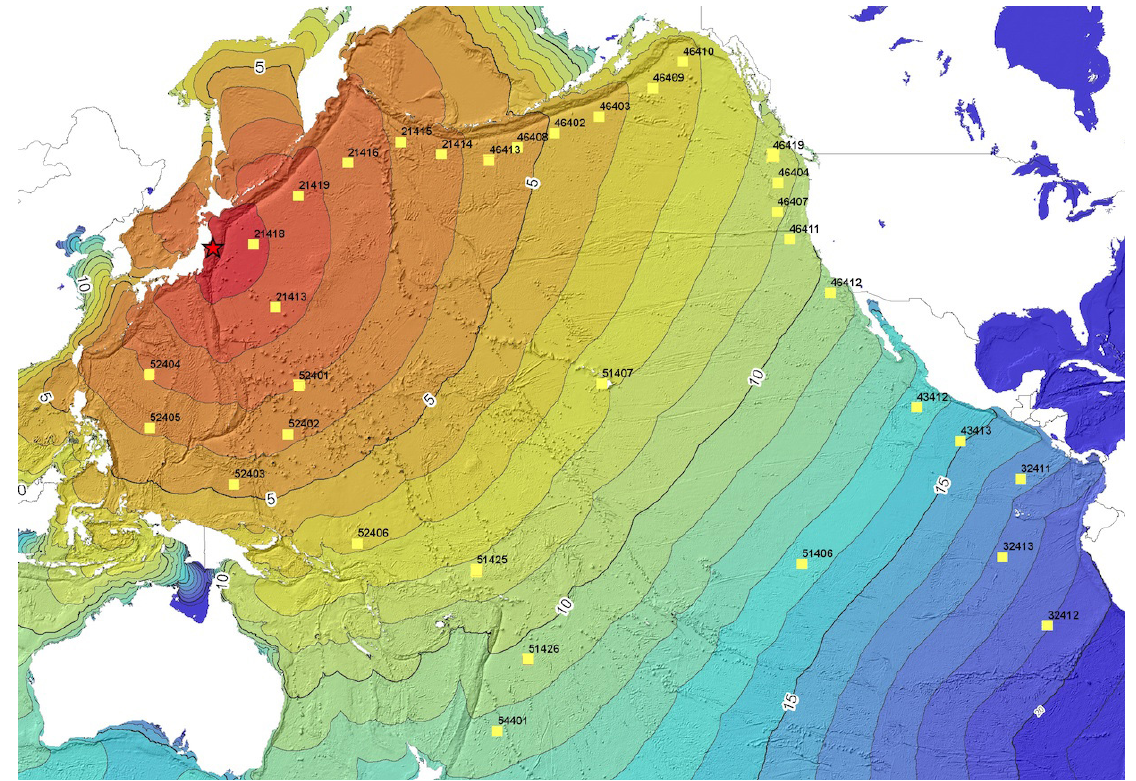
Figure 1. Tsunami wave travel time (in hours) and location of Pacific Ocean DART buoys used to quantify the wave height in deep ocean. The earthquake epicenter is indicated with a star. Image source: NOAA National Geophysical Data Center.